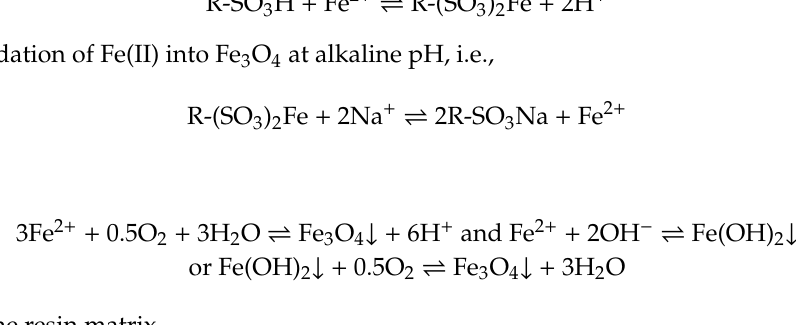
Figure 15. The Langmuir and Freundlich sorption isotherms of As(V) on X np -La(III) (pH 6, shaking speed 180 rpm, temperature 295 K). Table 6. The Langmuir and Freundlich parameters for adsorption of arsenic(V) on X np and X np -La(III) (pH 6, shaking speed 180 rpm, temperature 295 K).